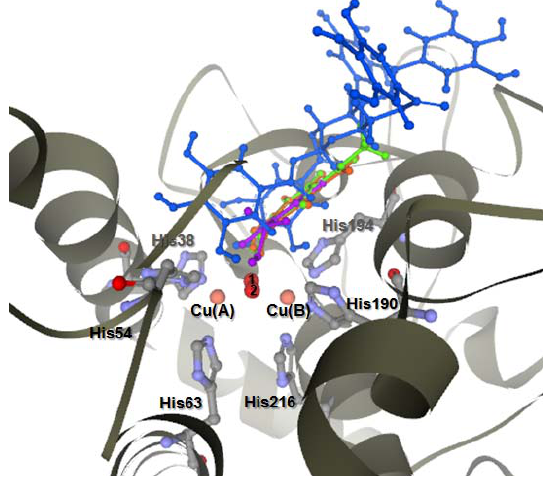
Figure 2. Docked conformation of ligand structures in the binding site of tyrosinase. KA (purple), PGG (blue), MG (green), GA-ionize